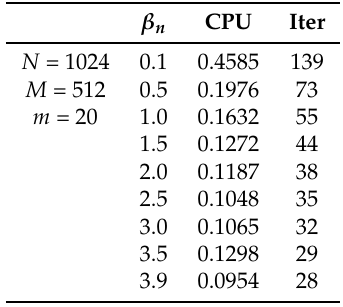
Table 3. The convergence behavior of Algorithm 4 with different cases of β n